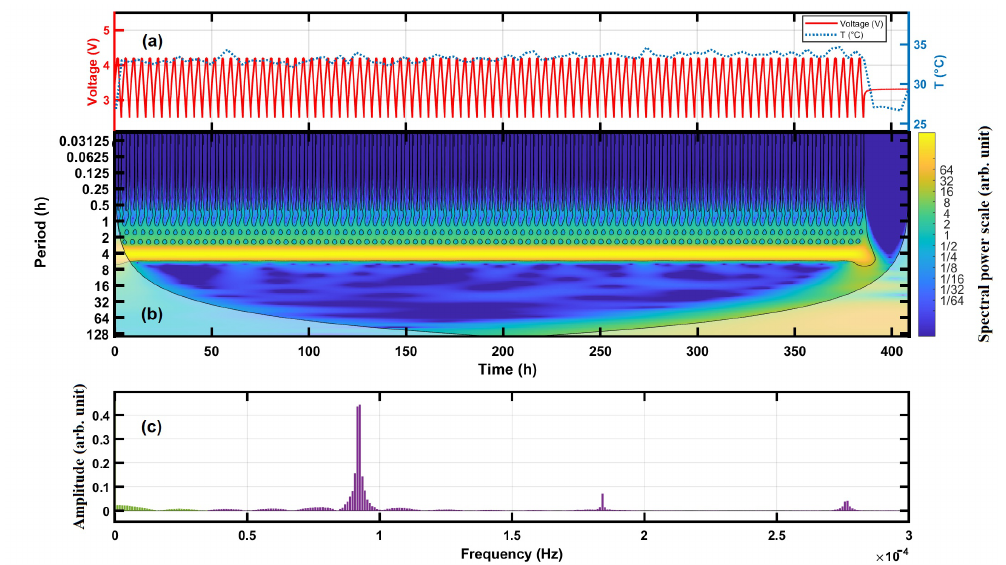
Figure 6. ( a ) Voltage and cell temperature, ( b ) wavelet spectral power, and ( c ) Fourier spectrum of the cycling test performed by UCL to one commercial cylindrical battery from the 110 to 202 cycles